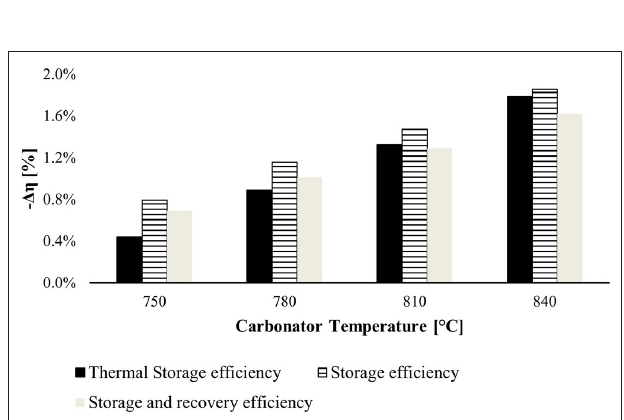
FIGURE 9 | Negative variation efficiency at different temperatures of the carbonator reactor. The reference efficiencies are computed at 720 ◦ C (minimum temperature of the carbonator reactor to provide heat to the power